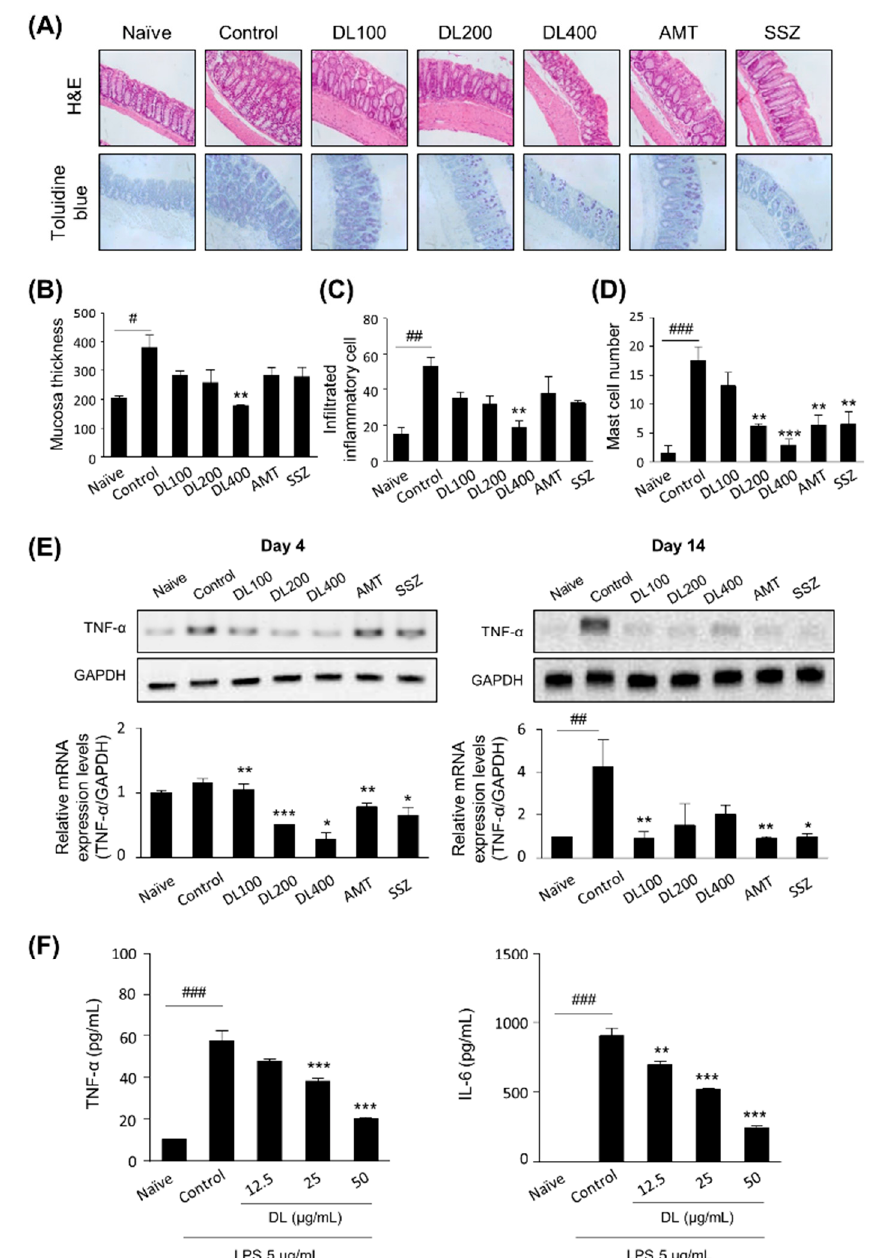
Figure 4. Effects of DL on colonic inflammation. Formalin-fixed colons were stained with ( A ) H&E and toluidine blue. Cells in the colon were visualized under a visible-light microscope at a magnification of 200 × . ( B ) The mucosa thickness were measured and ( C ) infiltrated inflammatory cells and ( D ) mast cells were counted by ImageJ software. ( E ) TNF- α expression levels and colon histology in zymosan-induced IBS mice. The level of TNF- α mRNA in the colon on days 4 and 14 were determined by reverse transcription polymerase chain reaction (RT-PCR). ( F ) Bone marrow-derived mast cells (BMMCs) were treated with various concentrations of DL for 1 h followed by stimulation with LPS for 6 h. Levels of TNF- α were determined by enzyme-linked immunosorbent assay (ELISA). The images represent one of three or six independent experiments. Data are presented as a mean ± SD ( n = 6, one-way ANOVA; ## p < 0.01, ### p < 0.001 vs. naïve; * p < 0.05, ** p < 0.01, *** p < 0.001 vs. control). H&E, hematoxylin and eosin; DL, D. lablab L. extracts; AMT, amitriptyline; SSZ, sulfasalazine; TNF- α , tumor necrosis factor- α ; LPS, lipopolysaccharides; GAPDH, glyceraldehyde-3-phosphate dehydrogenase.